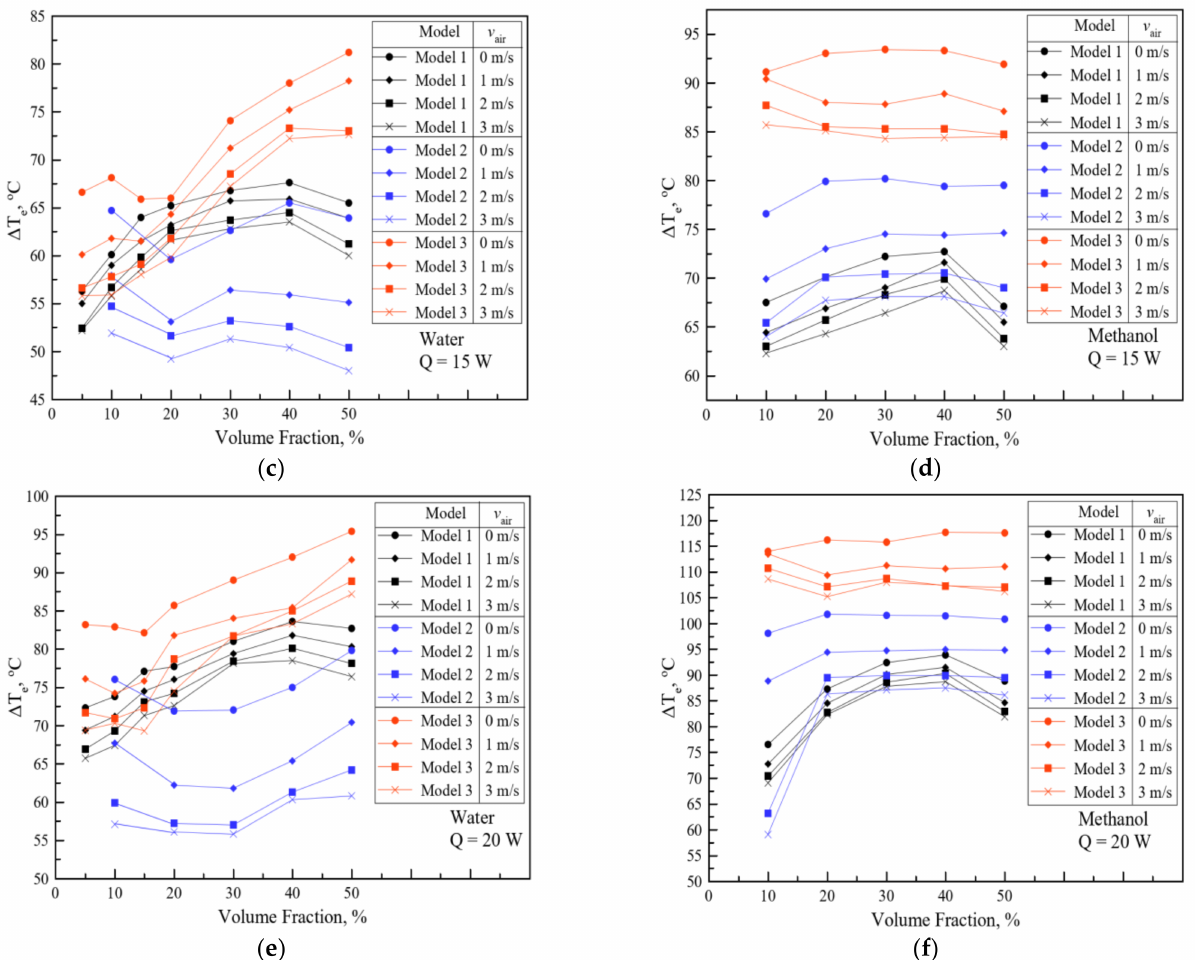
Figure 7. Effect of the volume fraction on the temperature difference with v air and heat flux. ( a ) Water, Q = 10 W. ( b ) Methanol, Q = 10 W. ( c ) Water, Q = 15 W. ( d ) Methanol, Q = 15 W. ( e ) Water, Q = 20 W. ( f ) Methanol, Q = 20